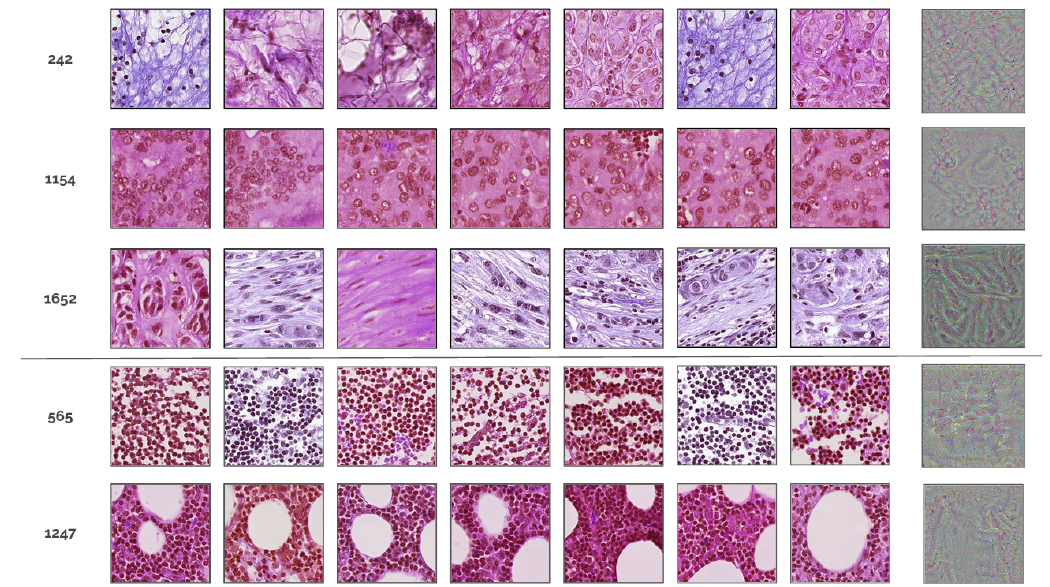
Figure 6. Patch-based visualizations obtained for features 242, 1154 and 1652 (for min-scores features); 565 and 1247 (for max-scores features); tiles and max activation images